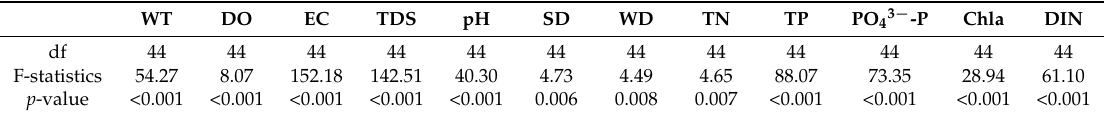
Table 4. The results of ANOVA of spatial